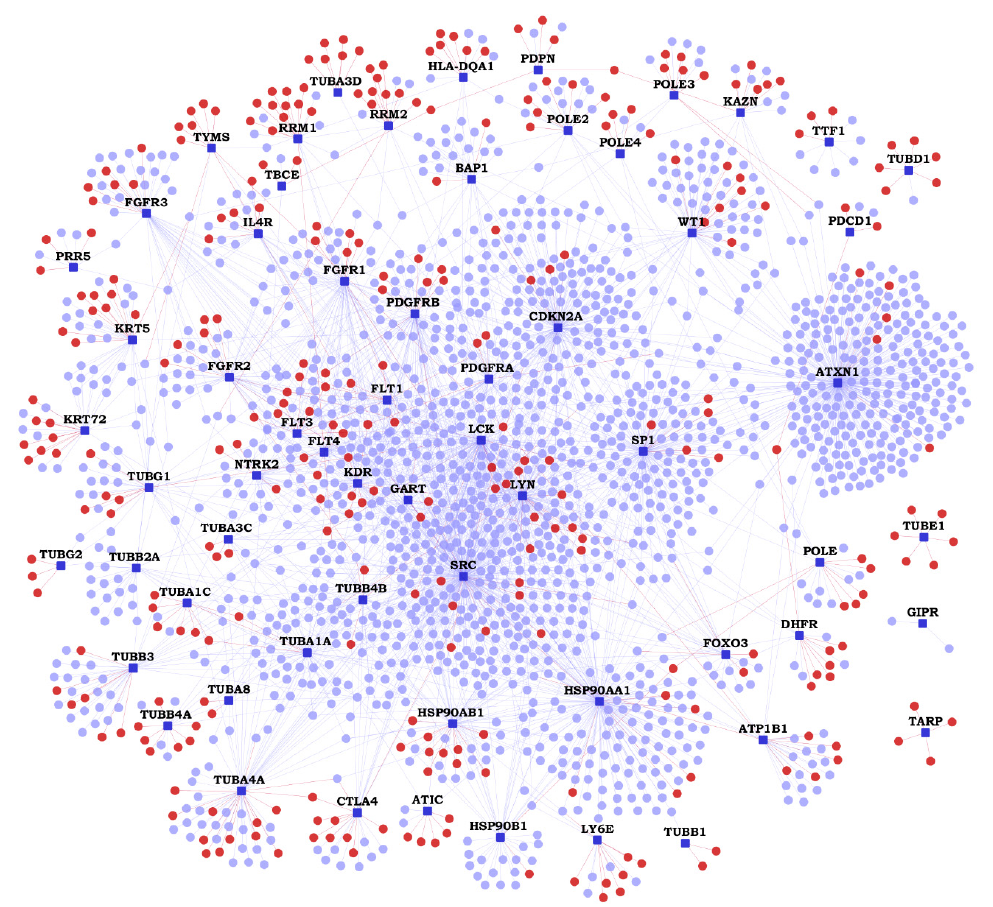
Figure 1. Malignant pleural mesothelioma (MPM) Protein-Protein Interactome : Network view of the MPM interactome is shown as a graph, where genes are shown as nodes and protein-protein interactions (PPIs) as edges connecting the nodes. MPM-associated genes are shown as dark blue square-shaped nodes, novel interactors and known interactors as red and light blue colored circular nodes respectively. Red edges are the novel interactions, whereas blue edges are known interactions.